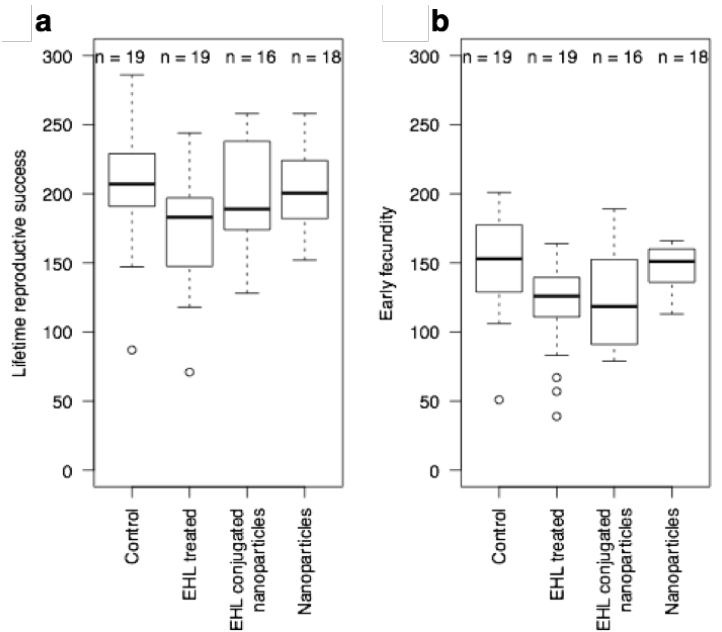
Figure 6. EHL conjugated nanoparticles (AuNPs@EHL) affect early reproduction ( b ), but not total reproduction ( a ) of C. elegans L4 stage.